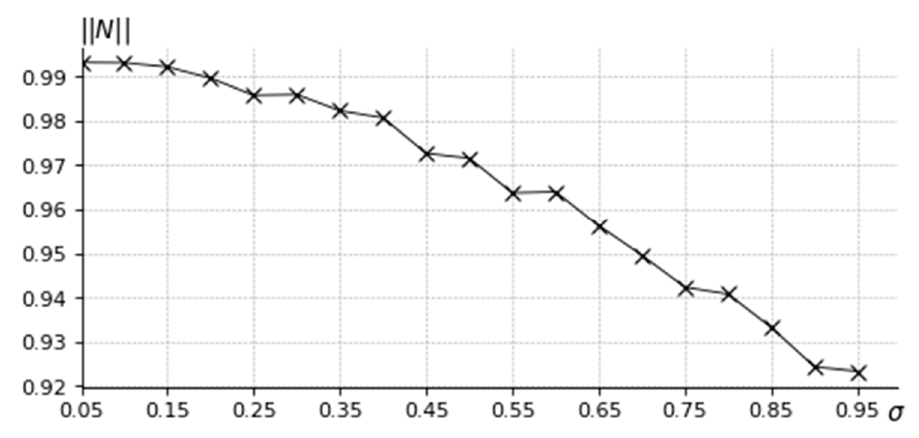
Figure 1. Cosine similarity norm versus σ .